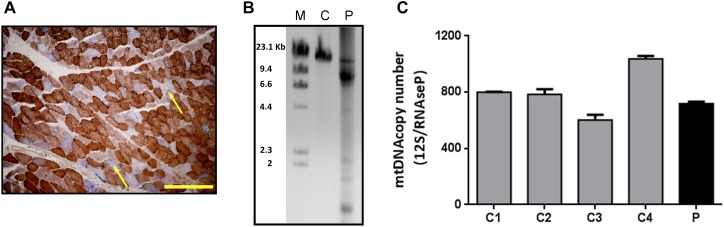
Histological and molecular findings in muscle biopsy specimens. (A) COX/SDH double staining of the patient’s muscle biopsy. The yellow scale bar represents 200 μm. Arrows show COX-negative fibers. (B) LPCR performed in DNA from the patient (P) and control (C) muscle samples. After electrophoresis, mtDNA deletions are seen as multiple bands in the agarose gel. (C) mtDNA copy number measured by qRT-PCR in skeletal muscle samples from patient (P) and controls (C1, C2, C3, and C4). Results are expressed as the ratio between the 12S mtDNA gene and the RNase P nuclear gene. Bars represent the mean (+SD, n = 3).